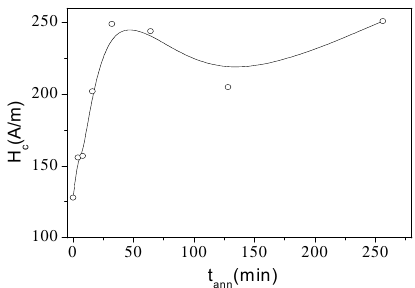
Figure 10. H c ( t ann ) dependence evaluated in Fe 62 Ni 15.5 Si 7.5 B 15 microwires. (Reproduced with permission from [81] Figure 2d Copyright © 2020 AIP Publishing LLC, Open Access).